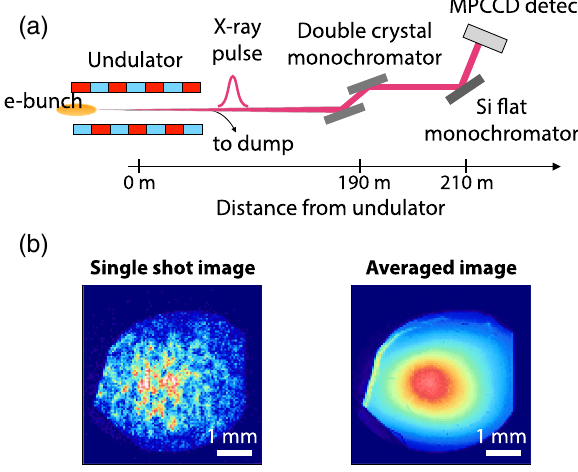
FIG. 1. (a) Schematic illustration of the x-ray HBT interfer- ometry performed at SACLA BL3. (b) Single shot and averaged images of the monochromatized spontaneous radiation for the case of the flat Si crystal in a reflective index of 111. The edge of the x-ray beam profile originated from the limited apertures of the beamline